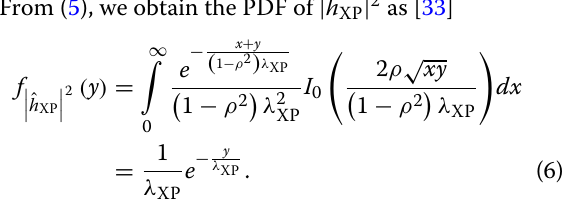
gain from node X to node Y, | h XY | 2 , is an